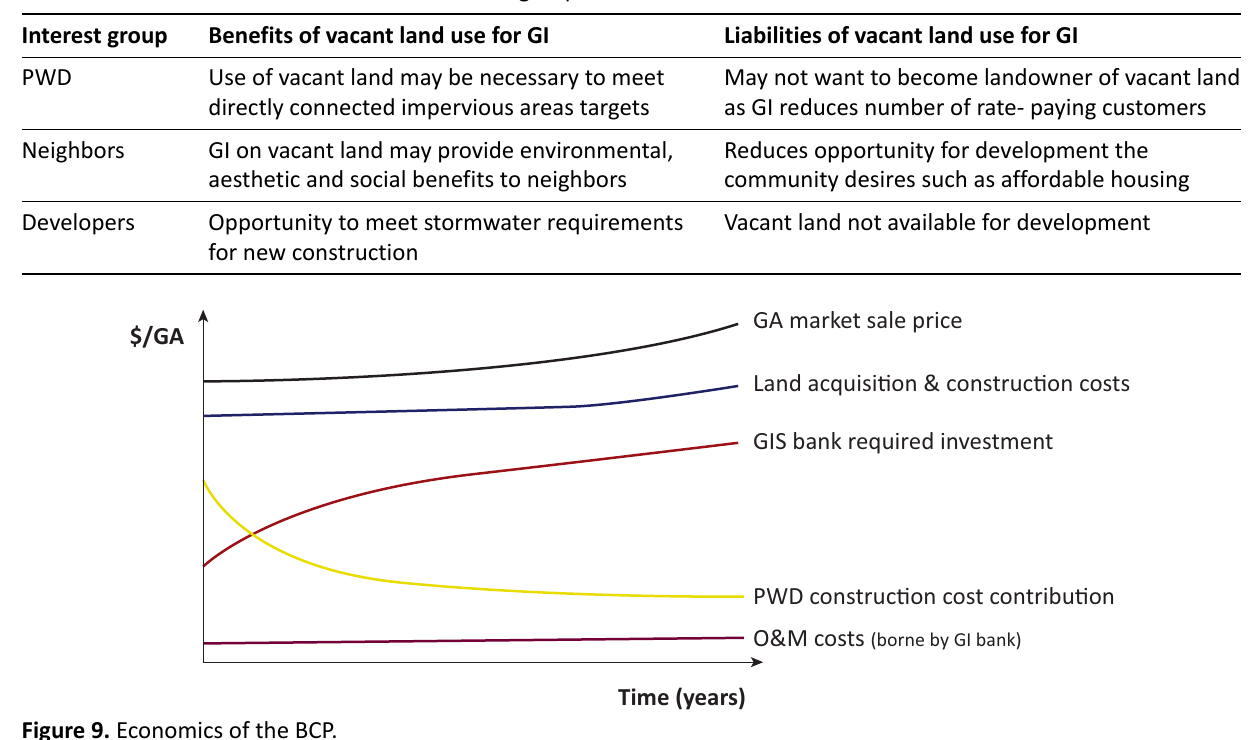
Figure 9. Economics of the